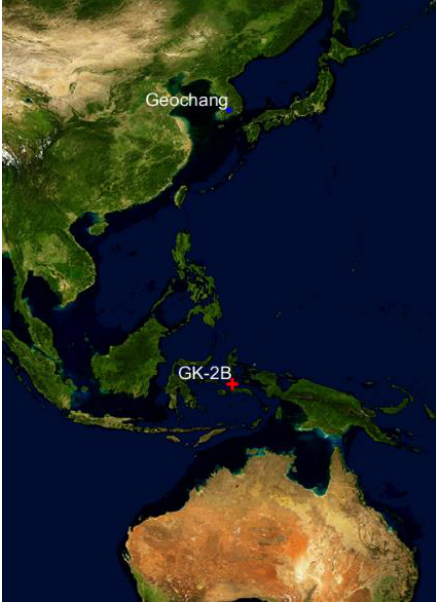
Figure 4. Ground trajectory of GK-2B (red cross) and Geochang station (blue dot).